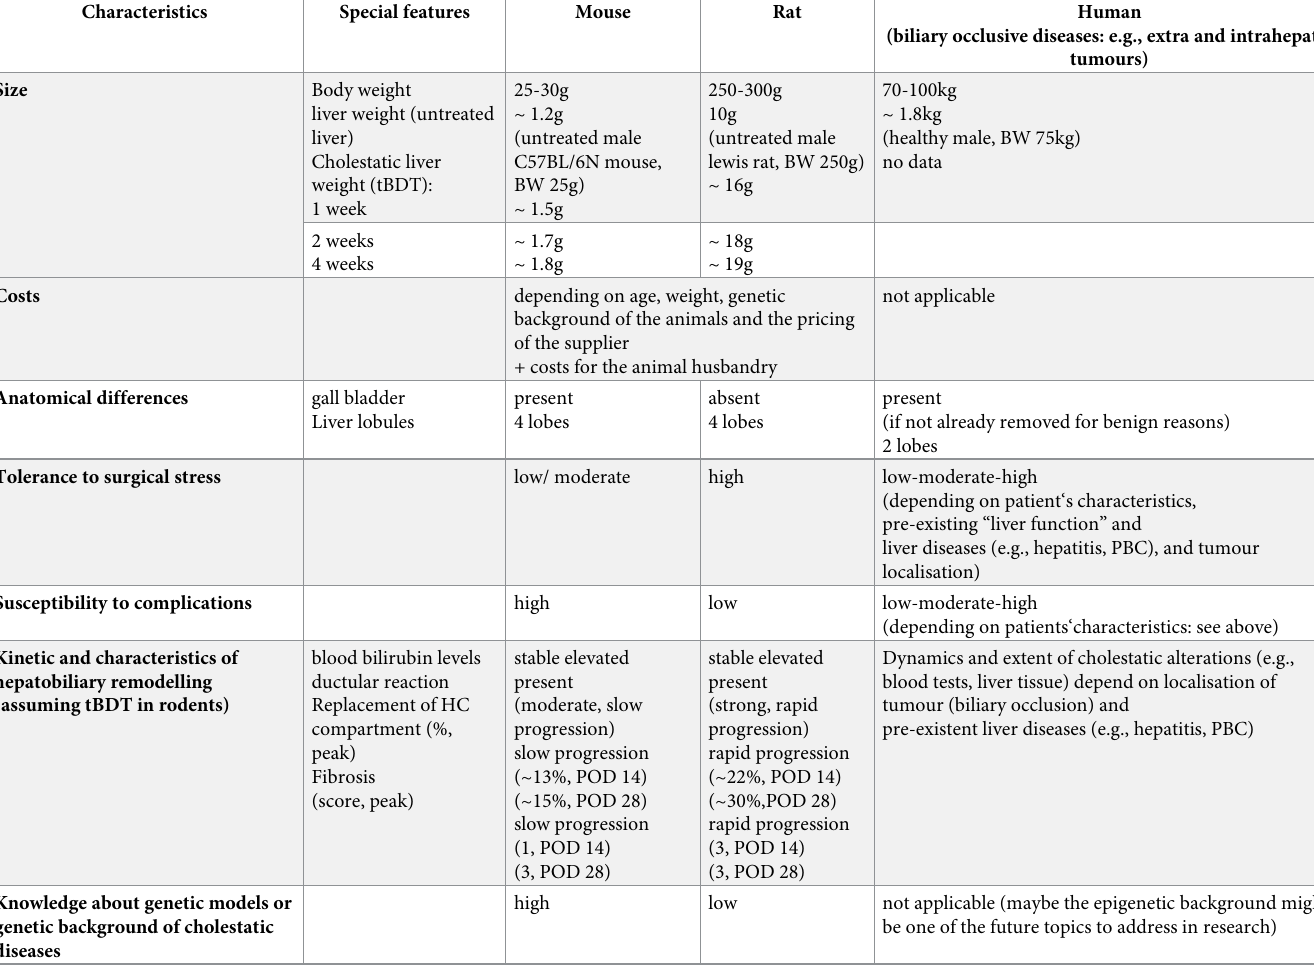
Table 6. Summary of characteristics of either species regarding hepatobiliary modelling after tBDT.